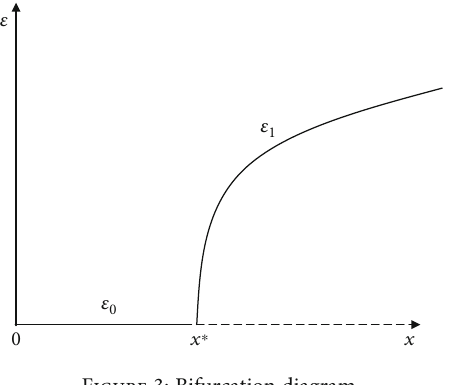
Figure 3: Bifurcation